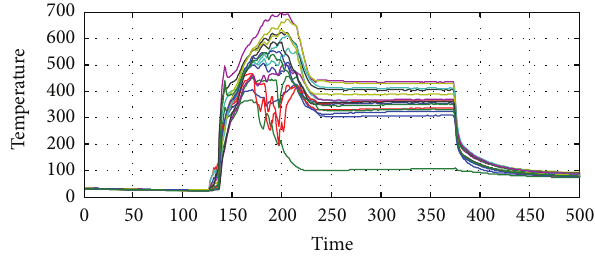
Figure 5: Uniformity of the temperatures (red dash line is the ideal case; blue line is the real